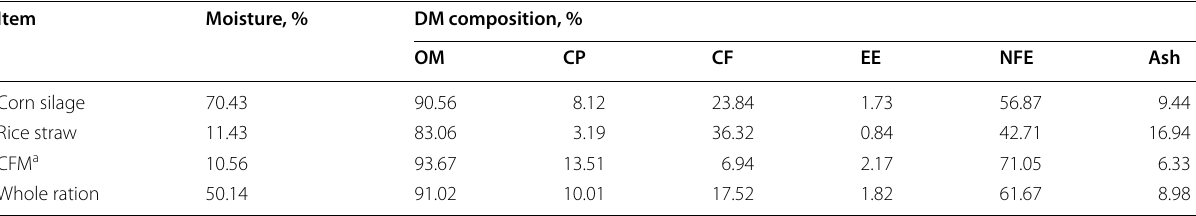
Table 2 Chemical composition of feedstuffs and the whole 50% roughage